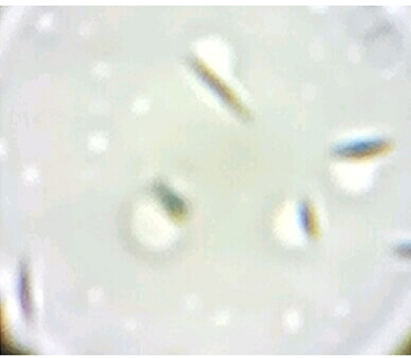
Figure 5: Microscopic morphology of niosomal complex suspension vesicles ( 1,000 ×) .